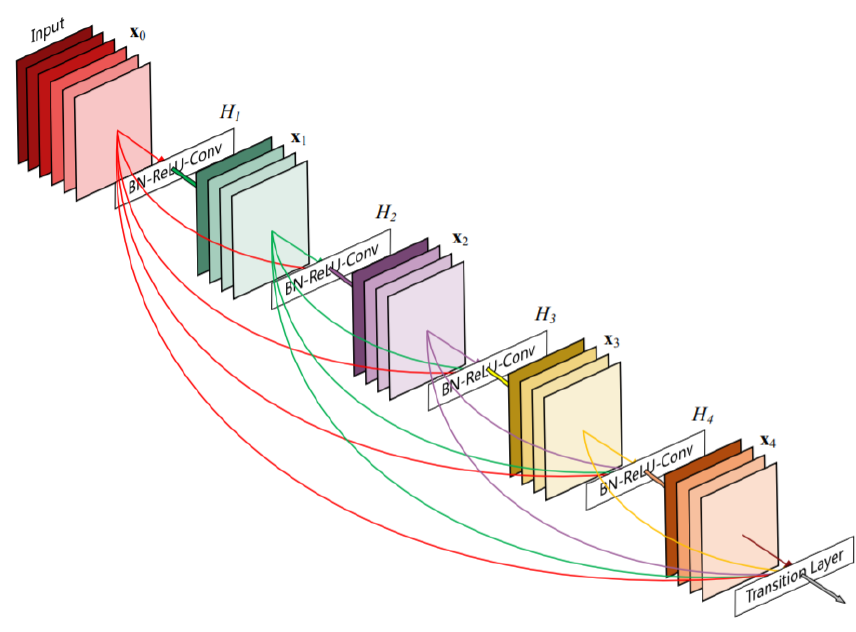
Figure 8. An illustration of a dense